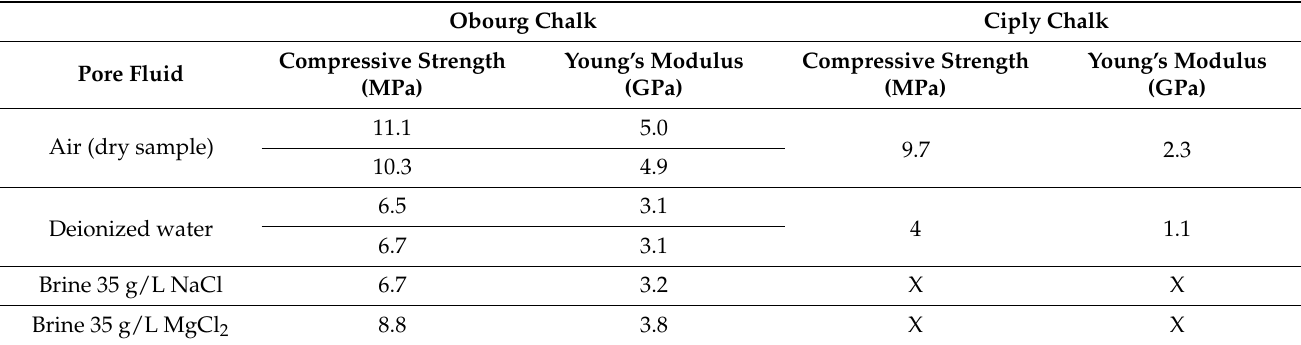
Figure 9. Triaxial tests at 1.5 MPa effective confining pressure for Obourg and Ciply chalks with different fluids saturating the pore space. The y -axis scale is the same for both plots. Table 4. Compressive strengths and elastic moduli for both chalks tested under dry and water-saturated conditions at 1.5 MPa effective confining pressure. Two Obourg chalk samples were tested in order to check the reproducibility of the experiments. Additional experiments were conducted on Obourg Chalk with two different brines saturating the